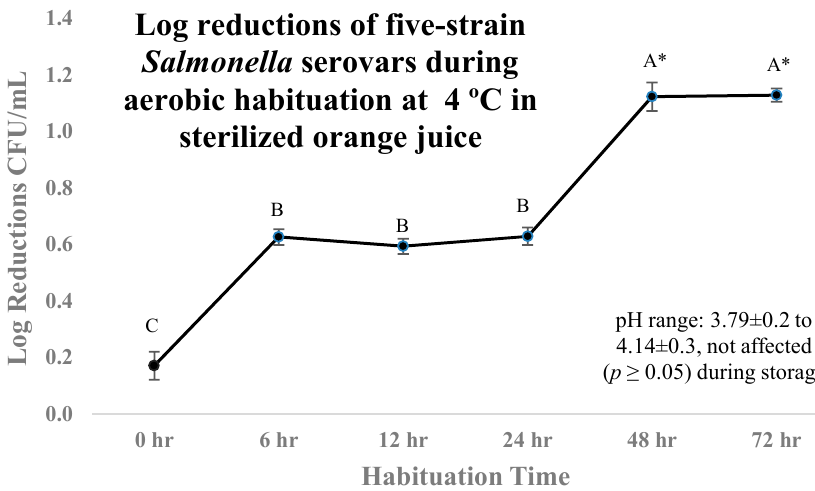
0.00.20.40.60.81.01.21.4 Figure 2. Number(s) of log reductions of five-strain mixture of Salmonella serovars (ATCC ® numbers 13076, 8387, 6962, 9270, 14028) inoculated in sterilized orange juice. Zero hour time shows the log reduction immediately after addition of the pathogen mixture to sterilized orange juices. Values followed by difference uppercase letters are statistically different ( p < 0.05), resulted from pair-wise comparisons of all six time intervals (Tukey-adjusted ANOVA). Values followed by * are statistically different ( p < 0.05) than control (8.68 ± 0.1 log CFU/mL), derived from comparisons of each time interval with the control (Dunnett-adjusted ANOVA).